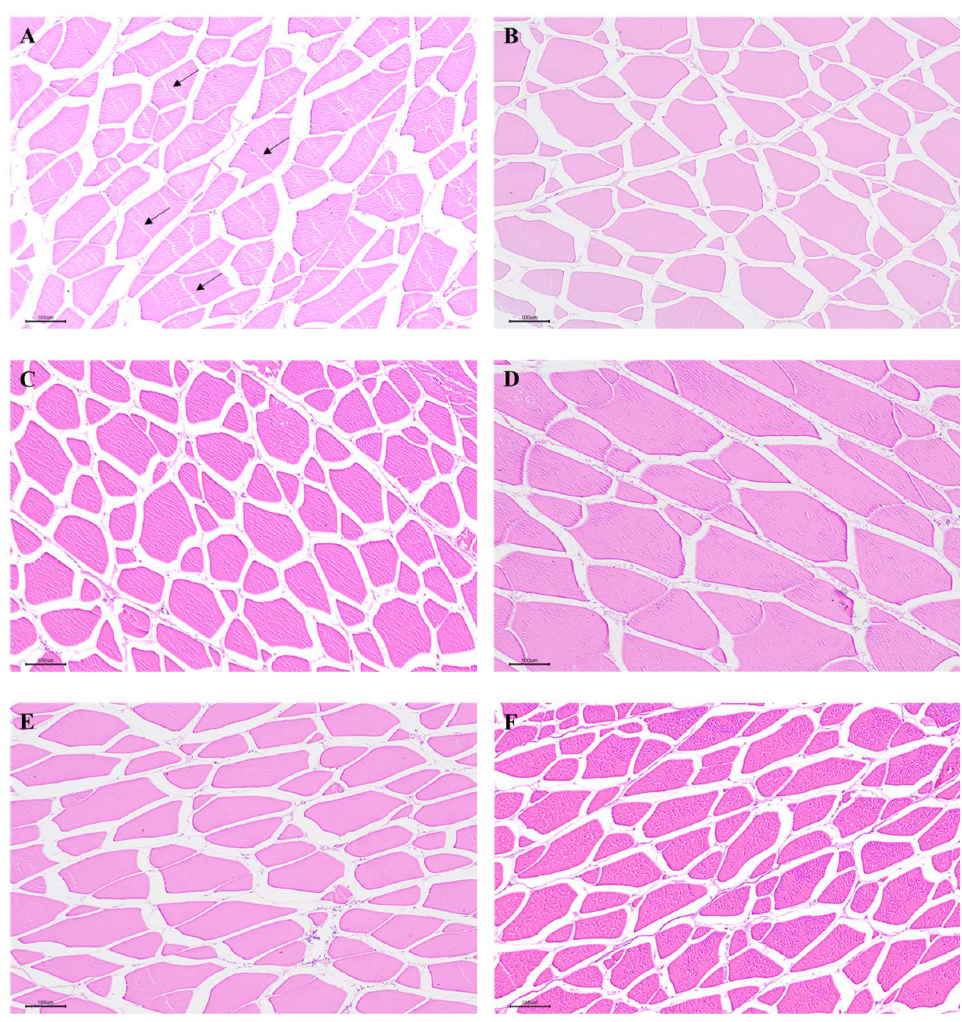
Figure 1. The histology of on-growing grass carp muscle (H&E 100×): ( A ) The vitamin A-deficient group. Arrowhead showed the rupture in muscle fiber. ( B ) The group with vitamin A at 606.8 IU/kg. ( C ) The group with vitamin A at 1209 IU/kg. ( D ) The group with vitamin A at 1798 IU/kg. ( E ) The group with vitamin A at 2805 IU/kg. ( F ) The group with vitamin A at 3796 IU/kg.